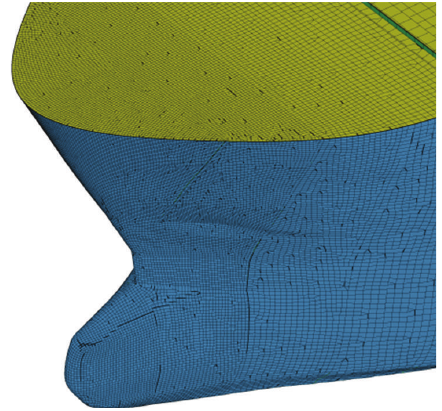
Figure 3: FEM for the ship.